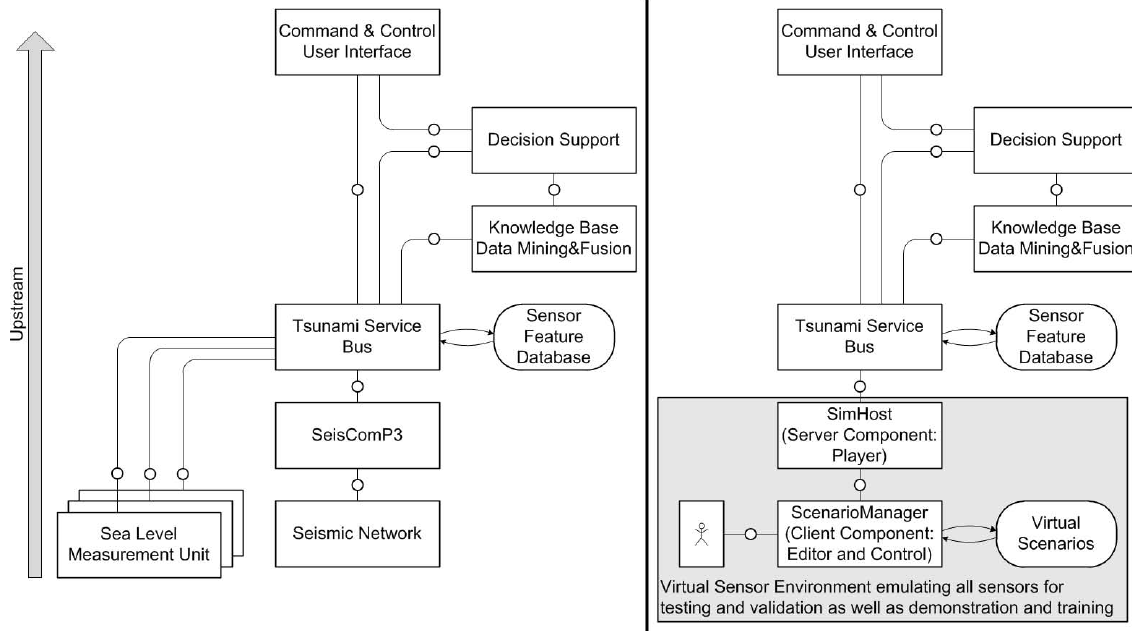
Fig. 11. System connected to real sensor environment (left), and connected to virtual sensor environment